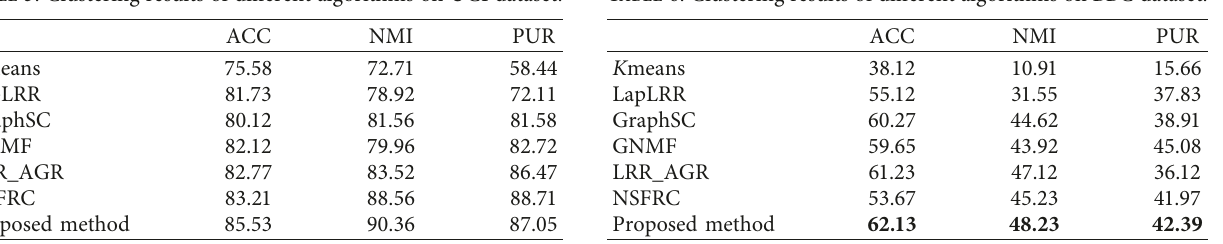
Table 3: Clustering results of different algorithms on UCI dataset.